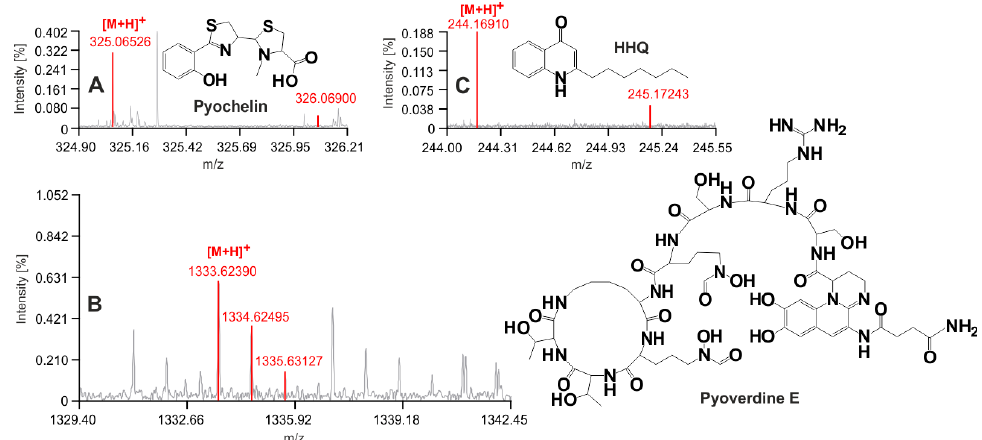
Figure 3. MALDI-FTICR-MS annotation of Patient 1’s breath condensate (sampled Day 12). Pch ( A ), PvdE ( B ), and HHQ ( C ) were all detected by MALDI MS as protonated forms. The structures of these molecules are shown. The annotation in red was returned by CycloBranch software [9] when running the MALDI mass spectrum against the library of P. aeruginosa secondary metabolites. The red color was added to an examined spectrum by the software automatically. The color indicates which isotope features have been used by the computing algorithm for the annotation process.